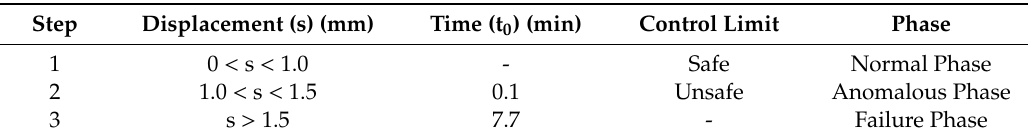
Table 2. Slope instrumentation management